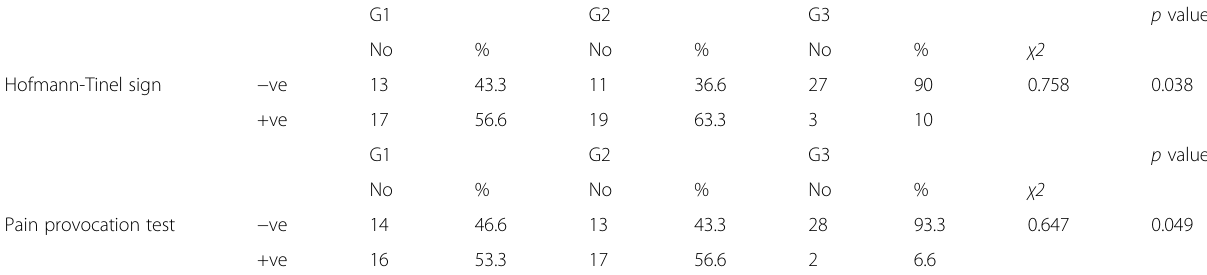
Table 4 Clinical signs of infrapatellar nerve entrapment/ injury among patients of the three studied groups in the affected side G1